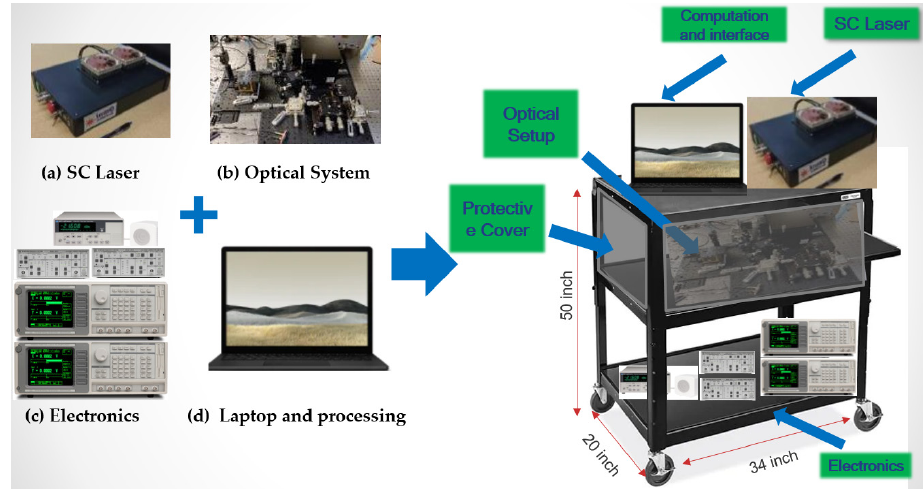
Figure 21. High-level system schematic of cart-based SCISCCO prototype.